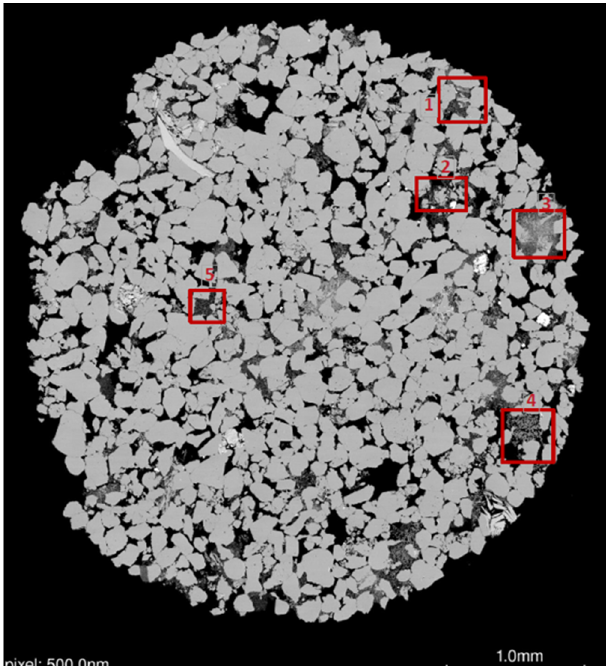
Figure 2. SEM image of the polished sub-plug slice before the reaction. Squares indicate the locations of images in the next figure.